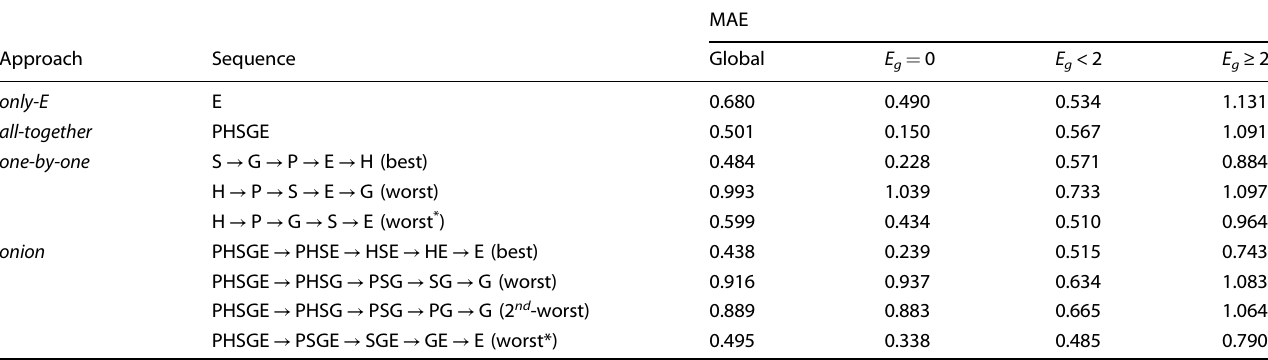
Table 1. Most representative results for the different training approaches and sequences without any